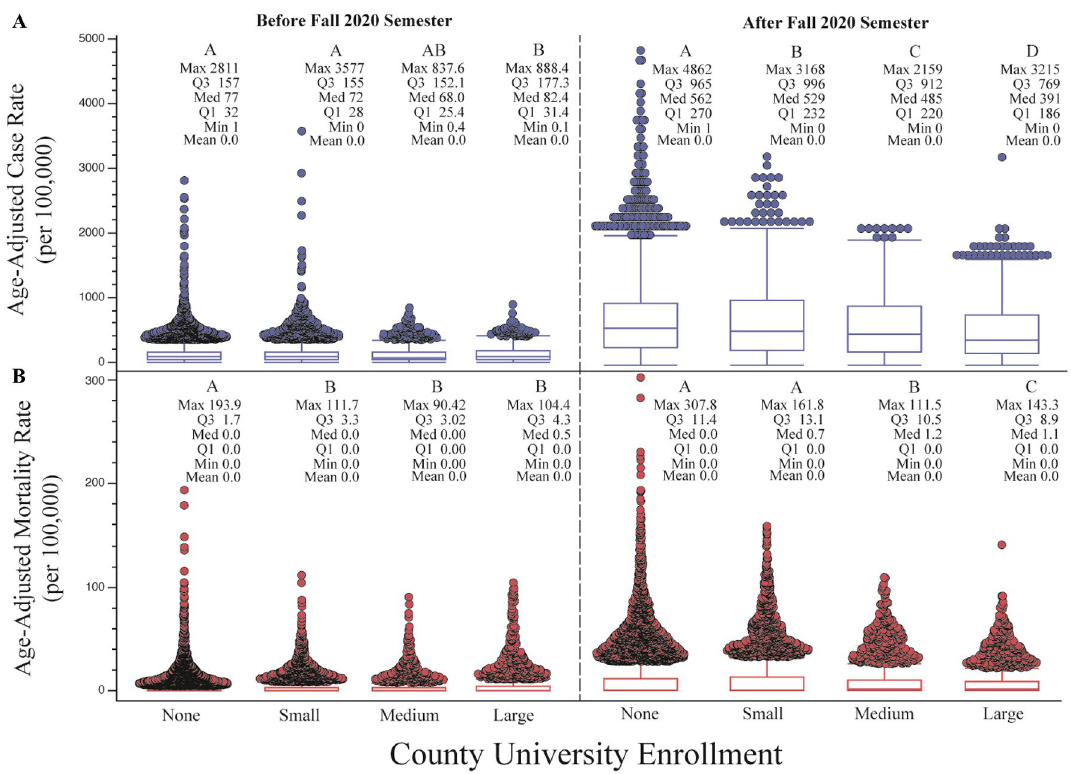
Figure 6. Box plot of mean SARS-CoV-2 age-adjusted case ( A ) and mortality ( B ) rates before and after the Fall 2020 semester period. The fall 2020 semester was assumed to begin September 1, 2020. Unique letters, arranged in descending order (highest mean value = A and so on), indicate statistically different groups (case and mortality rates, respectively; assessed by Student’s t-test, p value ≤ 0.05). Individual circles represent outlier